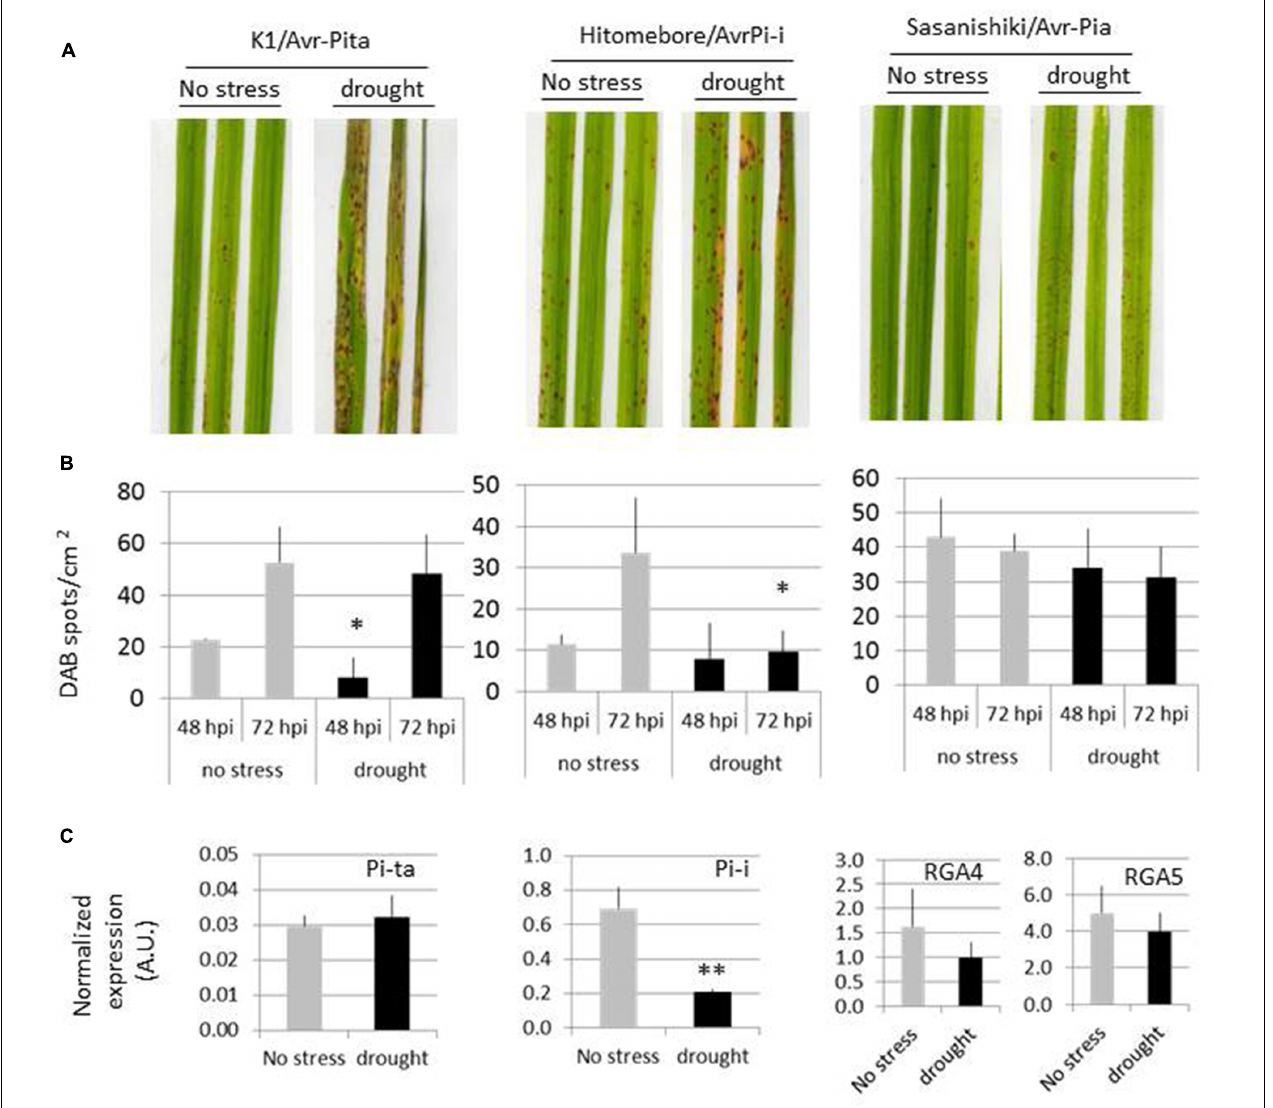
FIGURE 4 | Analysis of R gene-mediated resistance after drought. The indicated rice genotypes were grown, drought-treated and inoculated as presented in Figure 1 . Plants were spray inoculated with M. oryzae Guy11 isolate complemented with the indicated avr genes under their native promoter. (A) Macroscopic phenotypes were analyzed at 7 days after inoculation. (B) The oxidative burst was measured using DAB staining at the indicated time after inoculation. For each time point, a t -test was used to compare ROS production in non-stressed and drought stressed plants ( ∗ P < 0.05). (C) At the time of inoculation, the expression of the immune receptor recognizing the corresponding avr protein was measured by RT-qPCR and normalized with the rice Actin gene. For Pi-a, two immune receptors are involved (Cesari et al., 2013). A t -test was used to compare gene expression in non-stressed and drought stressed plants ( ∗∗ P <